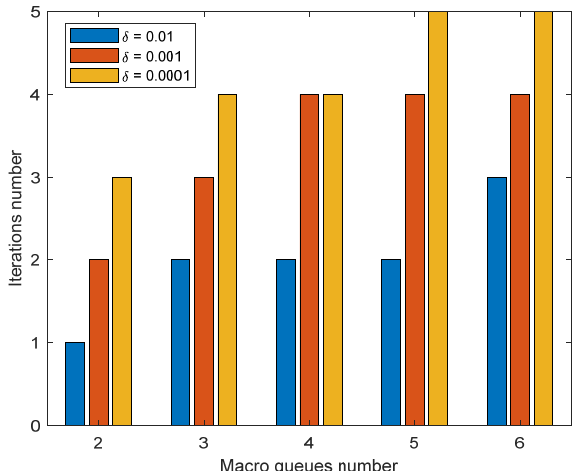
Figure 5. Dependence of coordination procedures (12) and (13) on iteration number required for method convergence to the optimal solution with the number of macro-queues.